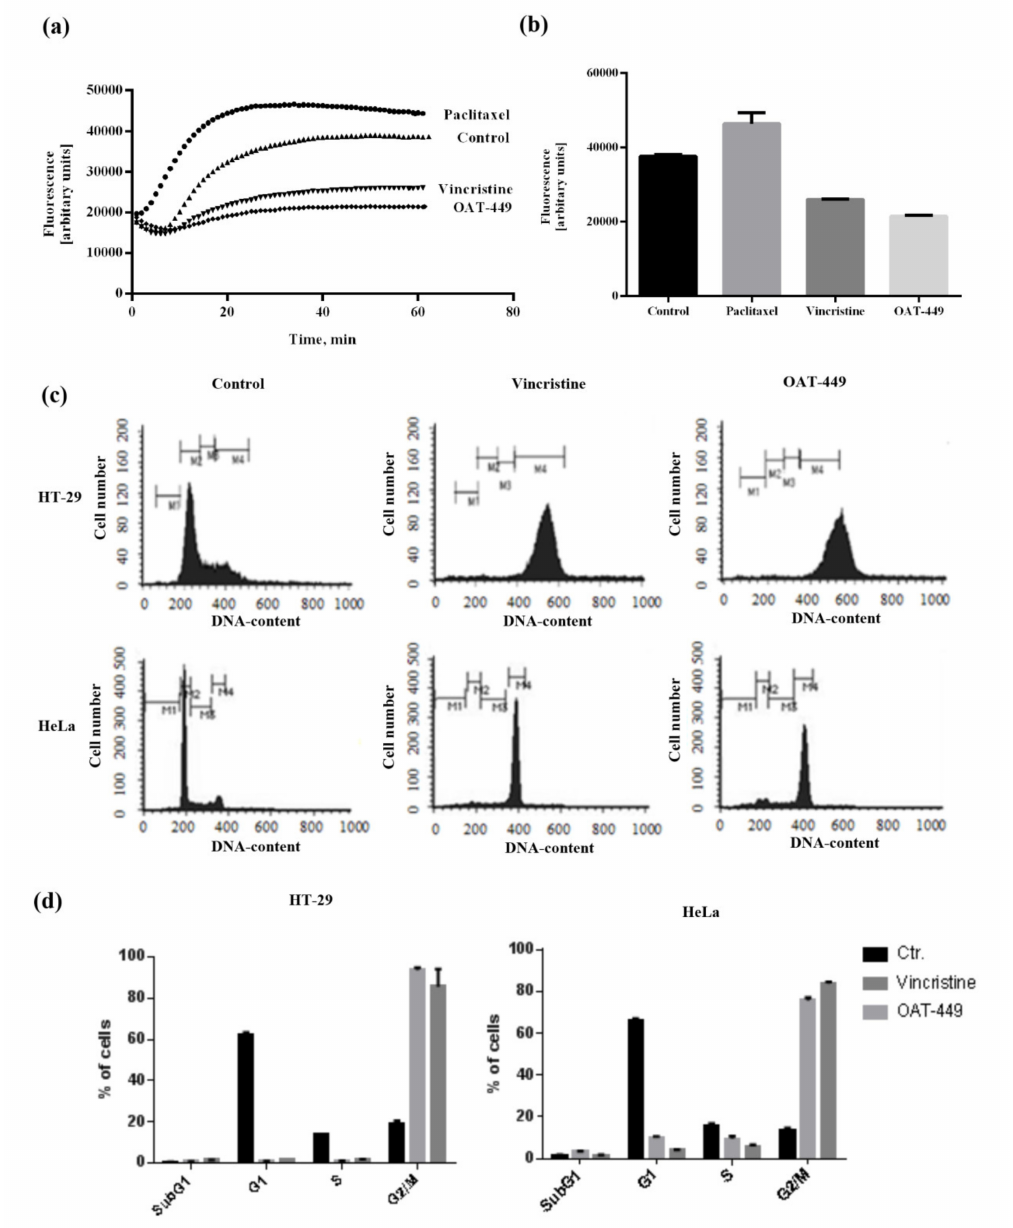
Figure 3. Both OAT-449 and vincristine inhibit tubulin polymerization and cell cycle progression. ( a ) In vitro polymerization activity of fluorescently labelled tubulin was monitored either in the absence (control) or following the addition of OAT-449 (3 µ M) or paclitaxel (3 µ M) (negative control) or vincristine (3 µ M) (positive control). ( b ) Graph represents a maximum value for each sample, mean ± SEM of at least 3 independent experiments. ( c ) Representative cell cycle profiles of HT-29 and HeLa cells treated with OAT-449 (30 nM), vincristine (30 nM) or DMSO (0.1%) as control, stained after 24 h with propidium iodide and analyzed by flow cytometry. Data shown are taken from 3 independent experiments. ( d ) Mean ± SEM of proportion of cells in di ff erent cell cycle stages, under specified treatment